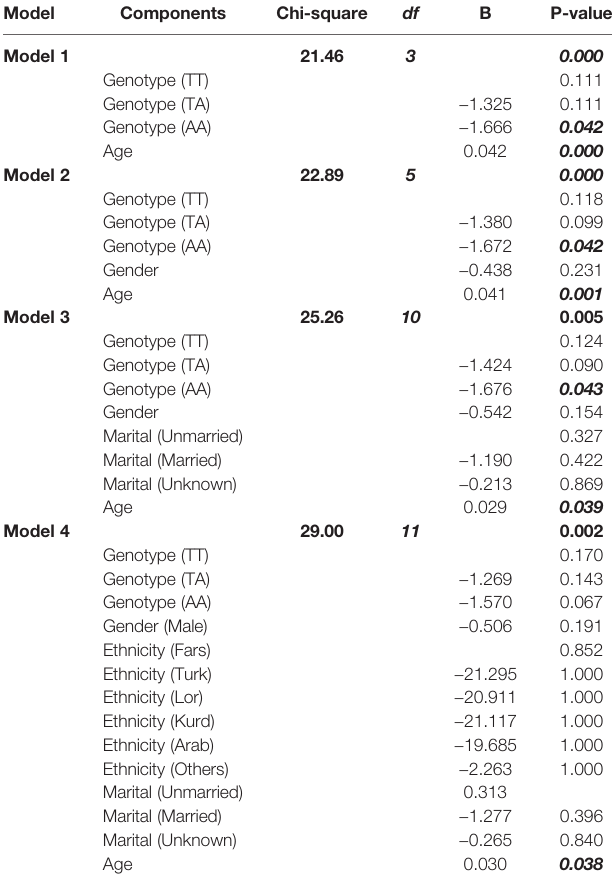
TABLE 3 | Beta estimates and con fi dence intervals for the association between FTO rs9939609 polymorphism and